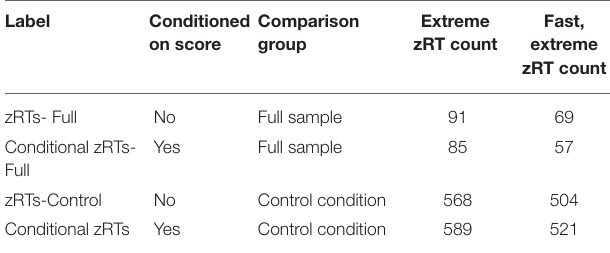
TABLE 3 | Comparing extreme results using different methods of computing zRTs.